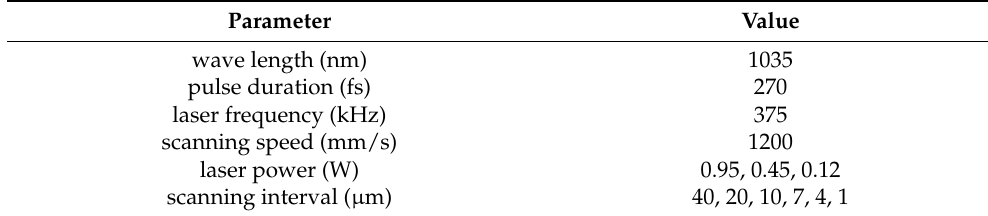
Figure 1. Experimental setup. Component abbreviations: LBEs: laser beam extenders; CCD: CCD camera; DM: dichroic mirror; CL: convex lens; SI: scanning interval. Table 1. Femtosecond laser processing